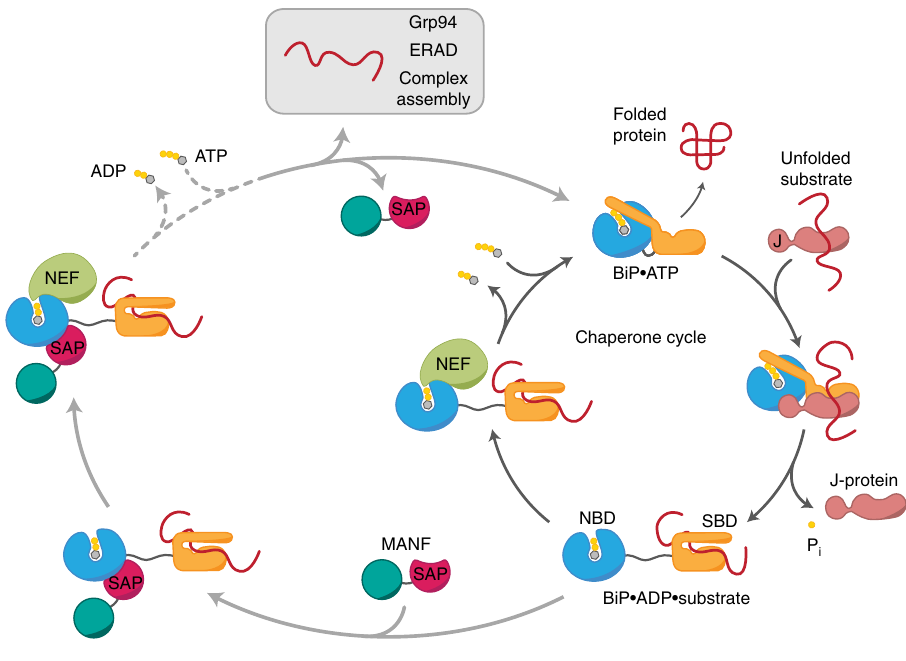
Fig. 7 Cartoon depicting the function of MANF as a nucleotide exchange inhibitor (NEI) for BiP. ER-localized BiP undergoes a J-protein- and nucleotide exchange factor (NEF)-dependent chaperone cycle (dark gray). MANF can interact with substrate-bound BiP in the ADP state, in which the nucleotide- binding domain (NBD) and substrate-binding domain (SBD) are undocked, to slow down nucleotide exchange and substrate dissociation (dotted line). By analogy to the role of the cytosolic Hip protein, MANF-mediated stabilization of certain BiP – client complexes may enhance the ef fi ciency of client transfer to downstream ER quality control effectors. These may include other chaperone systems (e.g., Grp94), degradation via ERAD, or factors involved